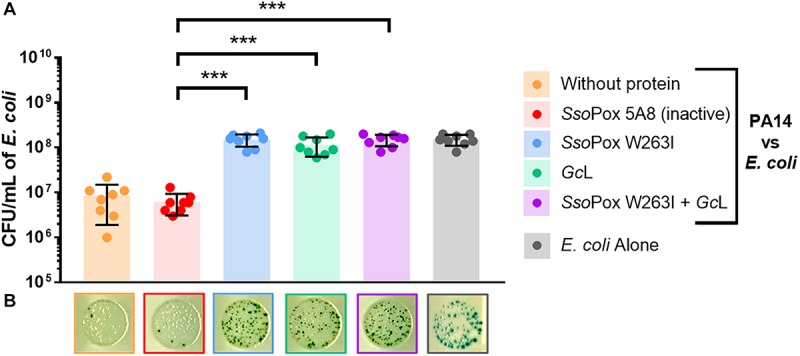
PA14 virulence toward E. coli is similarly reduced by both lactonases. (A) CFU count of E. coli and PA14 recovered after 24 h of incubation. For each active enzyme or their mixture, 2 U.mL–1 activity on 3-oxo-C12 HSL was used. The inactive variant SsoPox 5A8 was used at the same protein quantity as SsoPox W263I. All n = 8 independent samples are plotted with mean and standard deviation as colored histograms and black bars. Statistical significance according to Sidak’s multiple comparison test was highlighted by black stars (multiplicity adjusted pvalue < 0.05*, <0.01**, <0.001***) for E. coli count at 24 h. (B) Pictures of a representative dilution for each condition where surviving E. coli are visible as dark blue colonies.